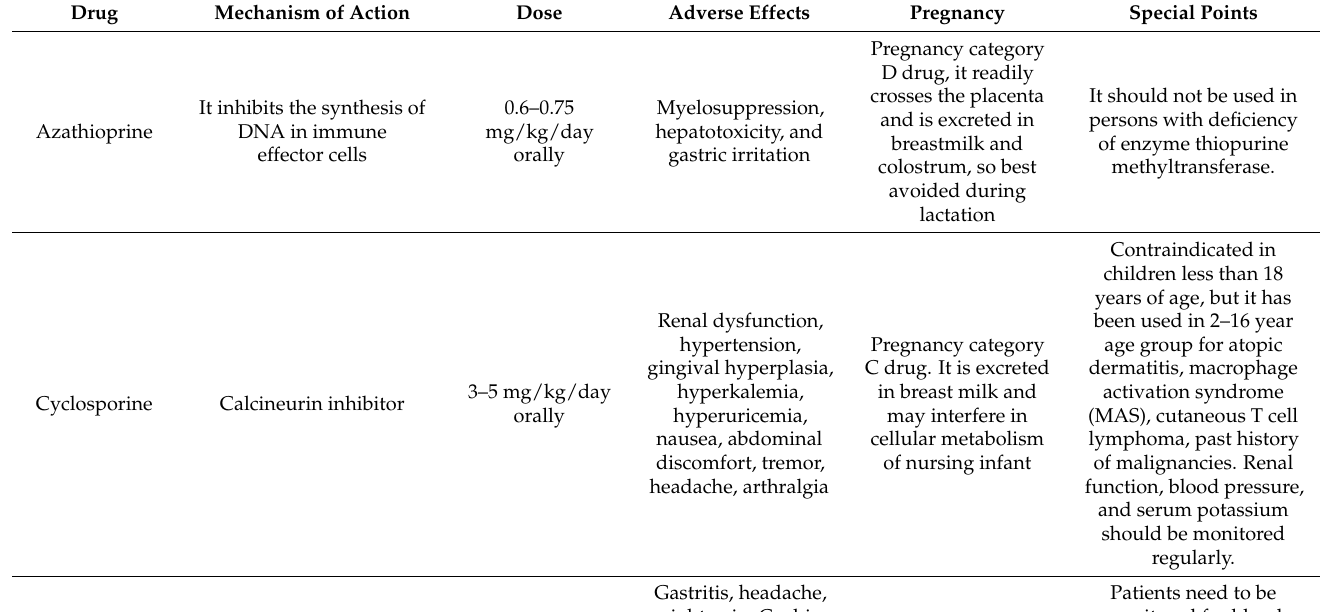
Table 1. Immunosuppressive drugs used for management of hidradenitis suppurativa